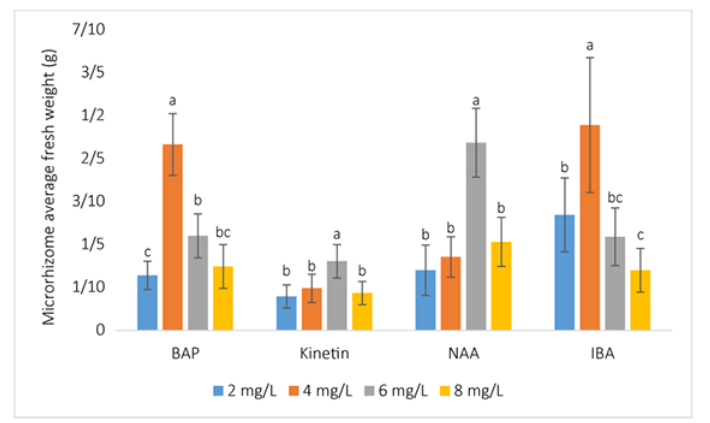
Figure 2 Effects of plant growth regulators (PGRs) on microrhizome fresh weight [mean ± t (29) × SE , where t (29) is the upper 0.025 critical value for the t distribution with 29 degrees of freedom]. The bell-shaped dose-respond curves were formed when the concentrations of PGRs increased from 2 to 8 mg/L, with the peaks of 0.433 g, 0.161 g, 0.437 g, and 0.478 g at the concentrations of 4 mg/L BAP (6-benzylamino purine), 6 mg/L kinetin, 6 mg/L NAA ( α -naphthaleneacetic acid), and 4 mg/L IBA (indole-3-butyric acid), respectively (within a group, means having a letter in common are not significantly different at the 5% level by Duncan’s test).